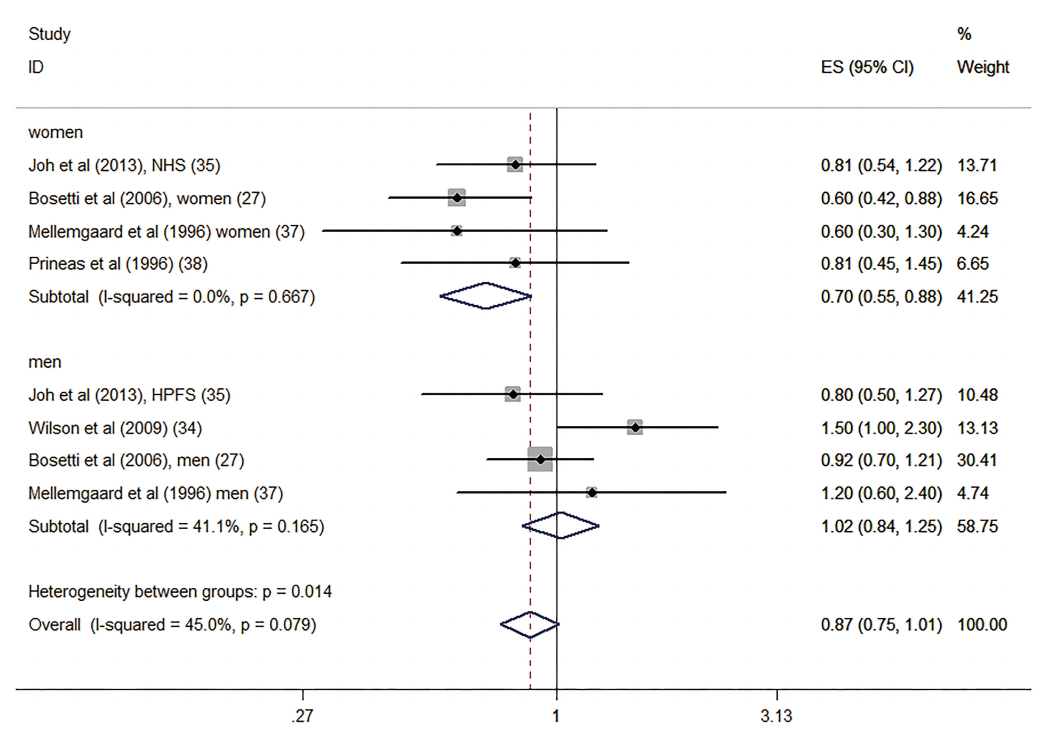
Figure 4 - Subgroup analyses of dietary vitamin D intake and risk of renal cell carcinoma in different gender.